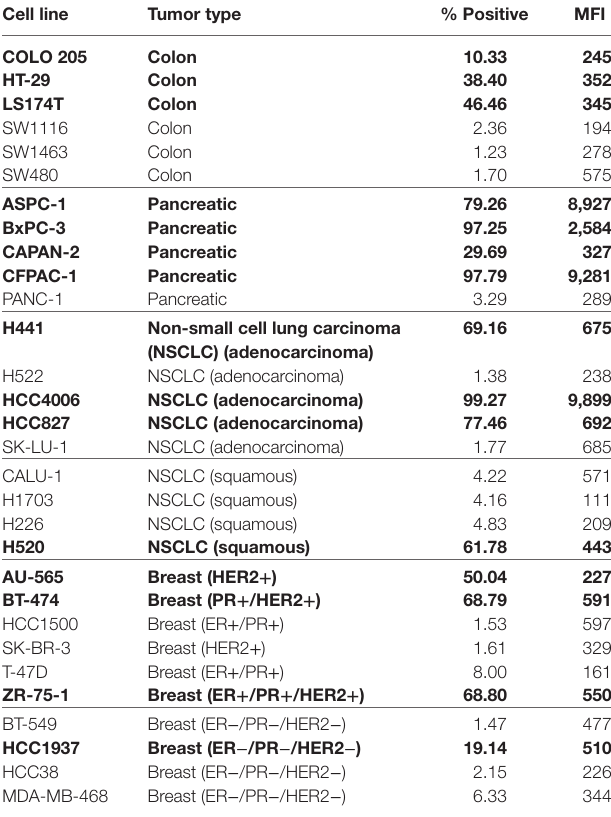
The percentage of positive cells and median fluorescence intensity (MFI) values are detailed for each cell line. NEO-201 positive cell lines appear in bold text. NEO-201 positivity was defined as % positive > 10%.